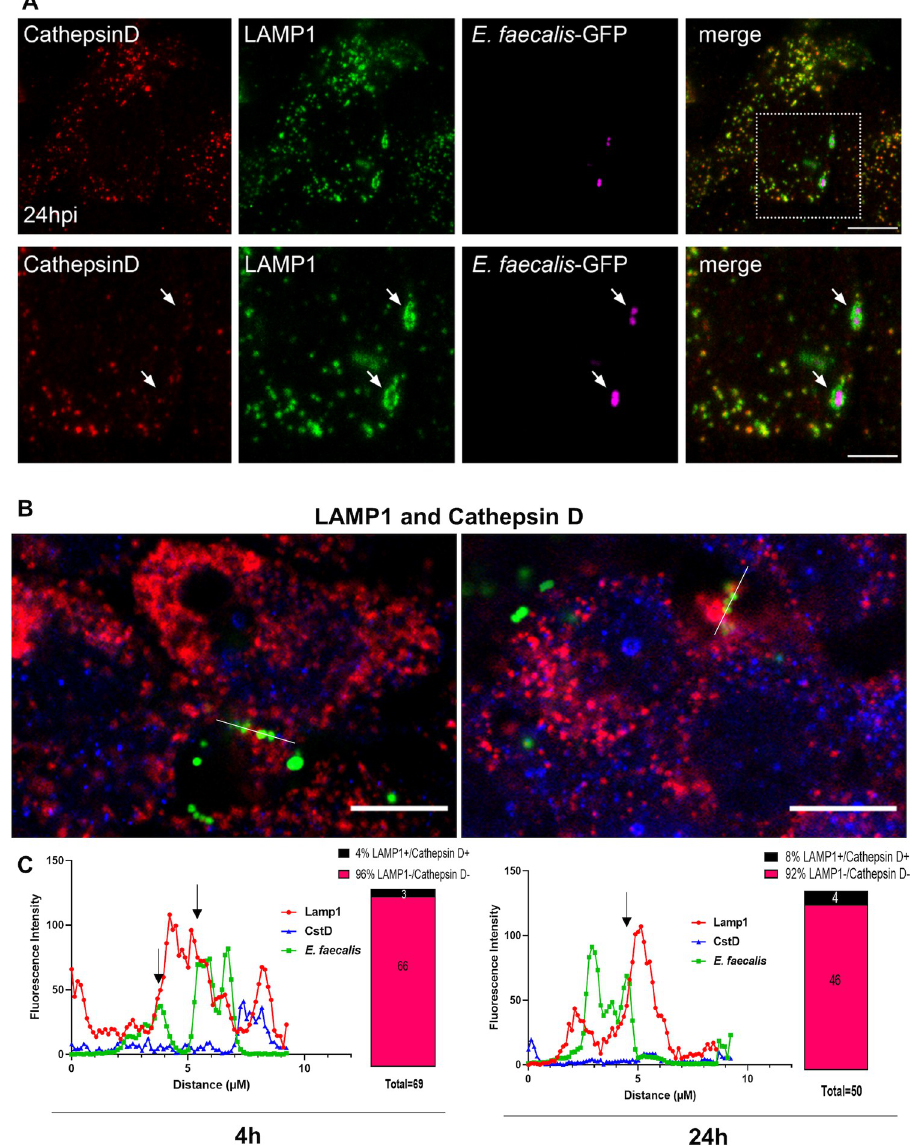
Fig 5. Intracellular E . faecalis escape lysosomal fusion with late endosome compartments. (A) CLSM of infected keratinocytes stained for the lysosomal protease Cathepsin D (late endosome/lysosome) and LAMP1 (late endosome/ lysosome; polyclonal antibody) at 24 hpi. Bottom panel shows the boxed region above. Images are maximum intensity projections of 4–5 optical sections (~2 μ m z-volume) and are representative of 3 independent experiments. Scale bars: top panel: 10 μ m; C bottom panel: 5 μ m. (B) CLSM of infected keratinocytes stained for the lysosomal protease Cathepsin D (late endosome/lysosome) and LAMP1 (late endosome/lysosome; monoclonal antibody) at 4 hpi and 24 hpi (C) Fluorescence intensity of Cathepsin D (Alexa Fluor 568, blue), LAMP1 (Alexa Fluor 647, red) and E . faecalis (pDasherGFP, green) were assessed over a linear segment (histograms) and scored as labelled by visualization of orthogonal views and 3D projections on Imaris 9.0.2. Arrow indicates points of colocalization. Images are representative of three independent experiments. Measurements (percentages) are derived from a minimum of 8 individual confocal images per time point (2–3 images per biological